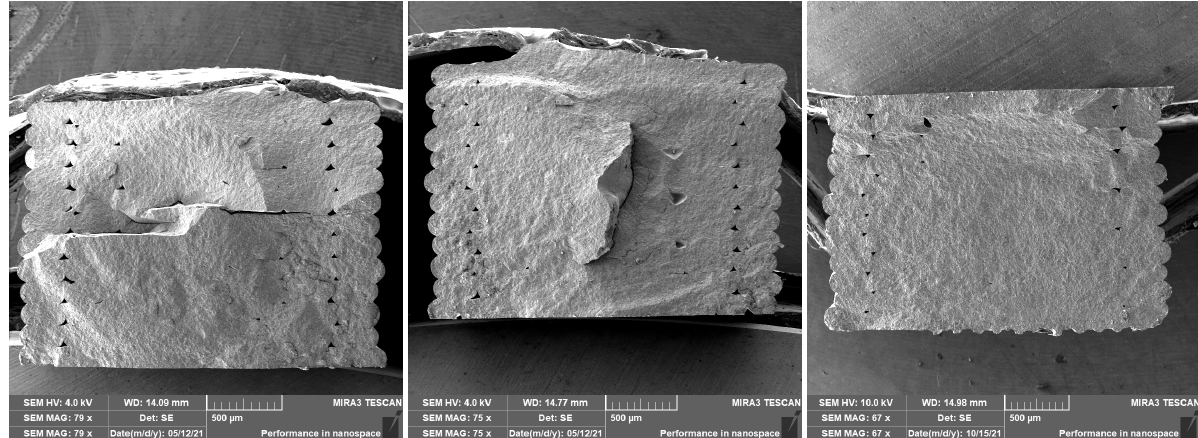
Figure 9. Fracture surface analysis with internall infill, left: 80%, 90%, and 100% infill.